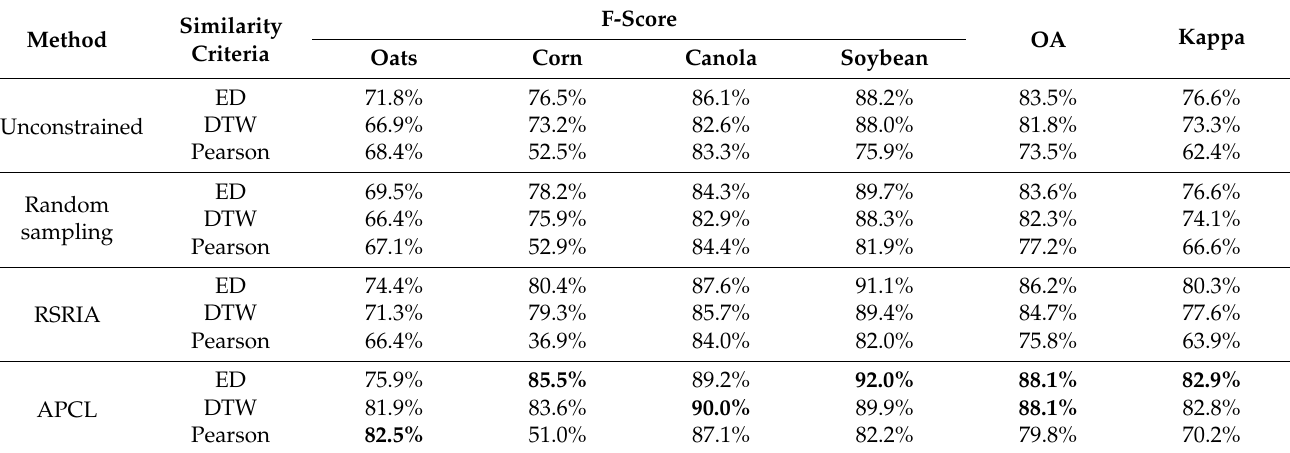
Table 4. Classification accuracy obtained by all